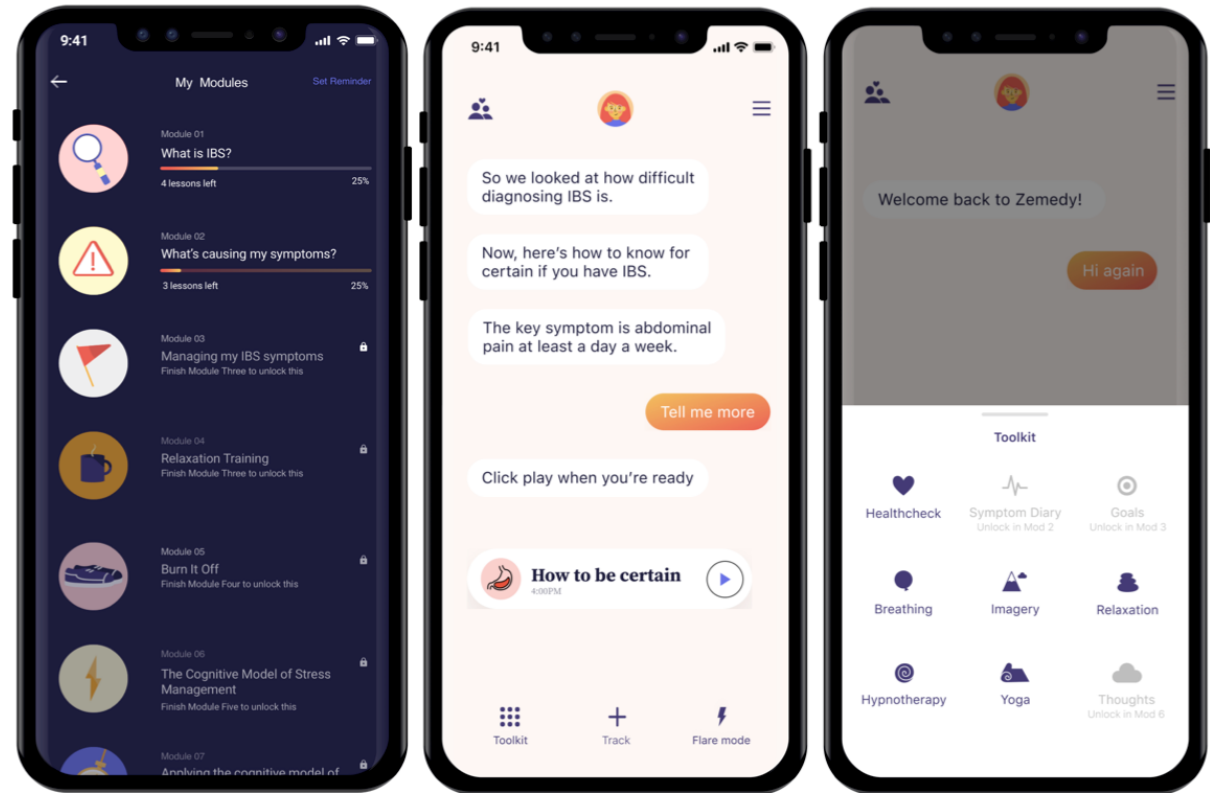
Figure 1. Screenshots of